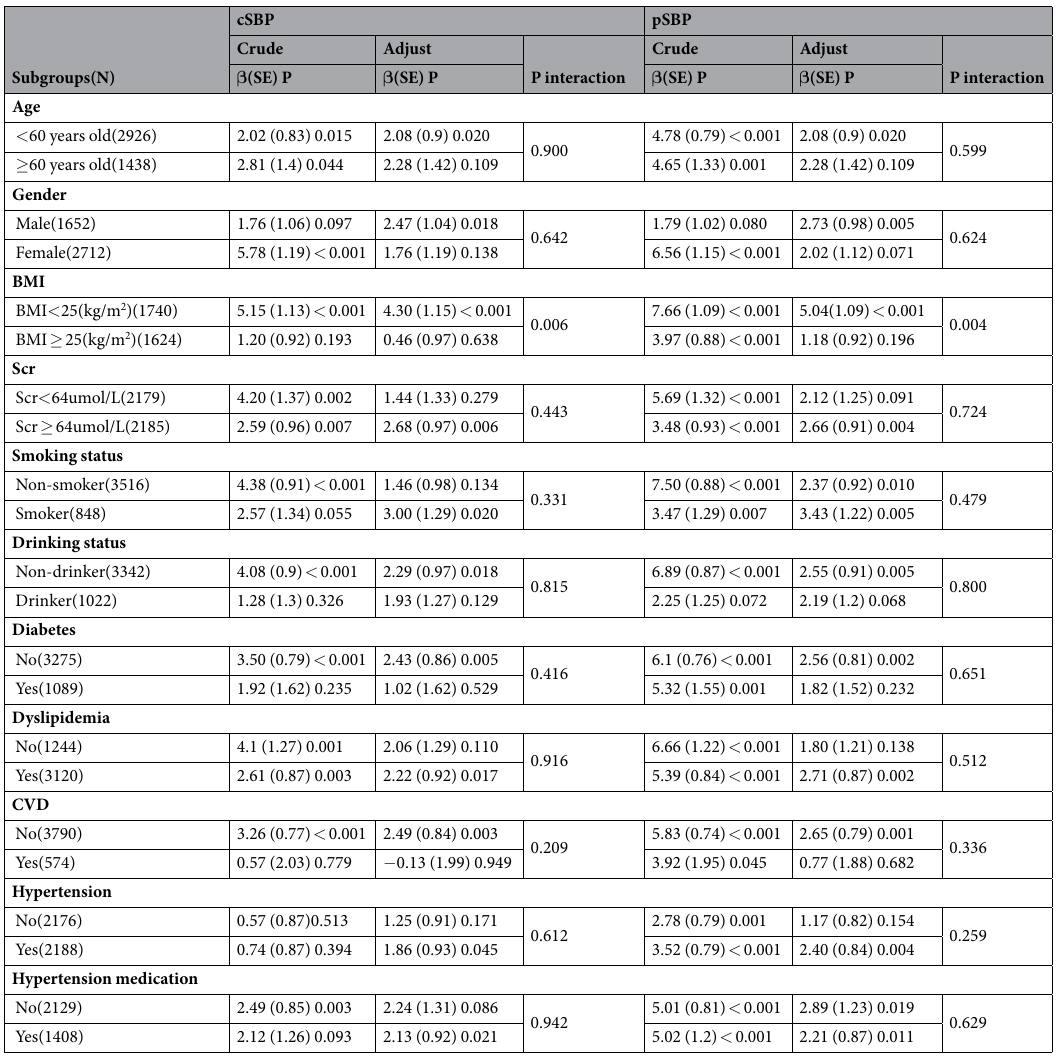
Table 3. Stratified and interaction analysis for effects of Hcy on cSBP and pSBP. Adjusted: age, sex, body mass index, smoking status, drinking status, serum creatinine, diabetes mellitus, dyslipidemia, cardiovascular disease, antihypertension drug use. Abbreviations: Hcy, homocysteine; Scr, serum creatinine; BMI, body mass index; cSBP, central systolic blood pressure; pSBP, peripheral systolic blood pressure; DM, diabetes